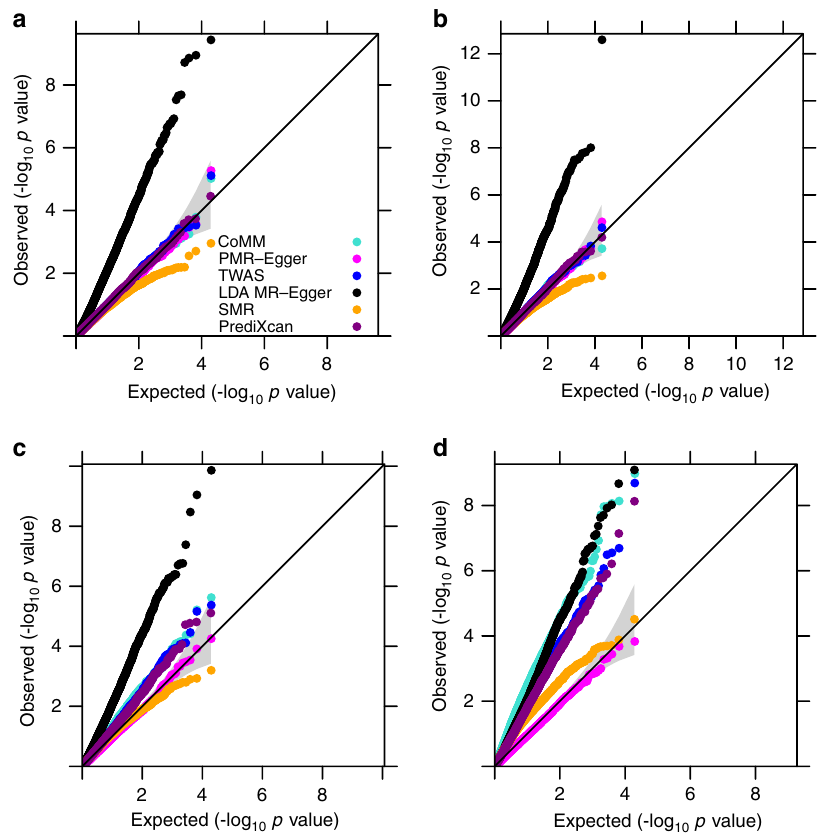
Fig. 1 Type I error control for different methods on causal effect testing. Quantile – quantile plot of − log10 p -values from different methods for testing the causal effect either in the absence or in the presence of horizontal pleiotropic effect under null simulations. Compared methods include CoMM (turquoise), PMR-Egger (magenta), TWAS (blue), LDA MR-Egger (black), SMR (orange), and PrediXcan (purple). Null simulations are performed under different horizontal pleiotropic effect sizes: a γ = 0; b γ = 0.0001; c γ = 0.0005; d γ = 0.001. Only p -values from PMR-Egger adhere to the expected diagonal line across a range of horizontal pleiotropic effect